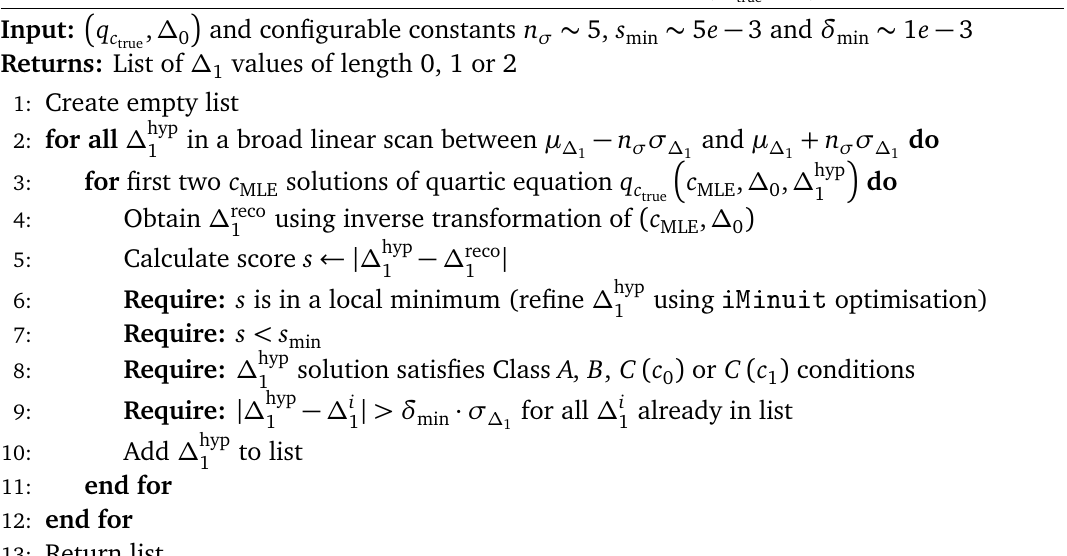
consistent with a given 1